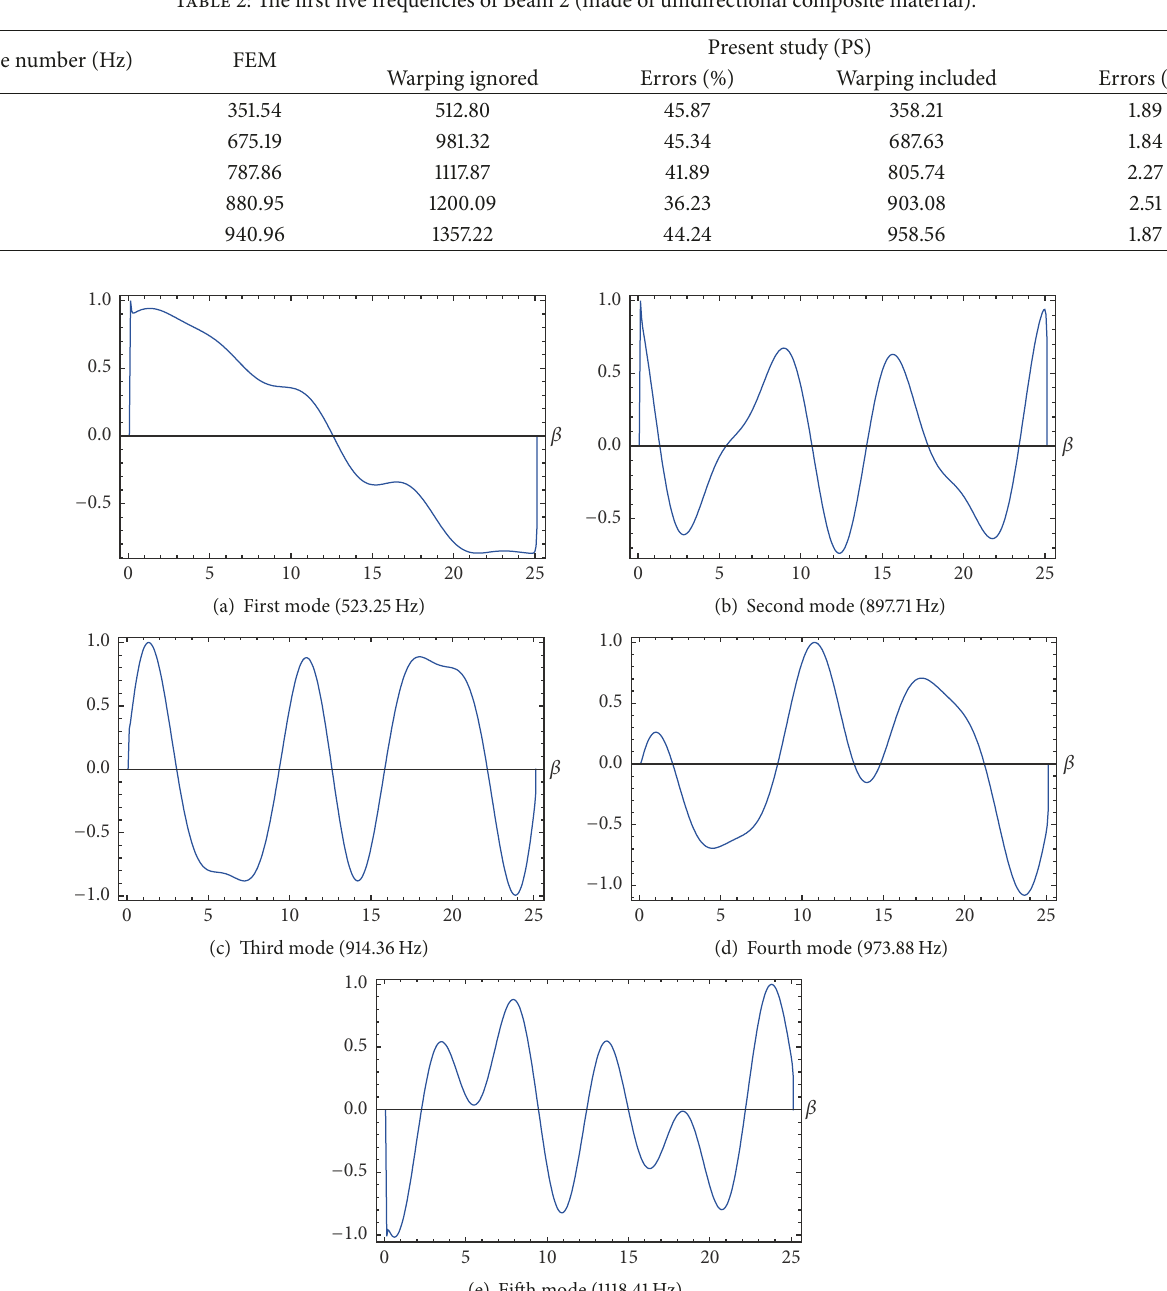
Table 2: The first five frequencies of Beam 2 (made of unidirectional composite material).